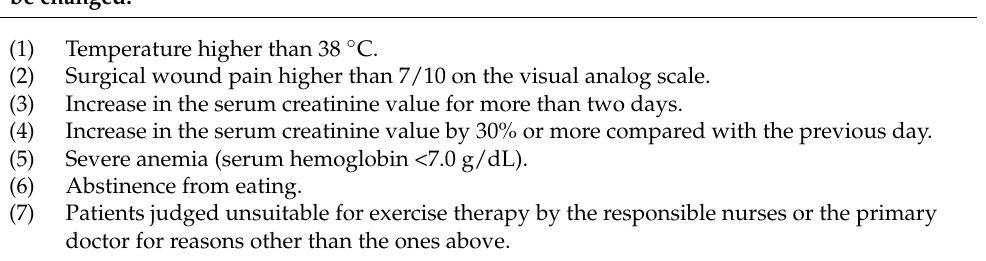
Table 3. Key points to note for safe implementation of exercise interventions among patients after kidney transplantation, created based on a reference from Yamamoto S. et al.